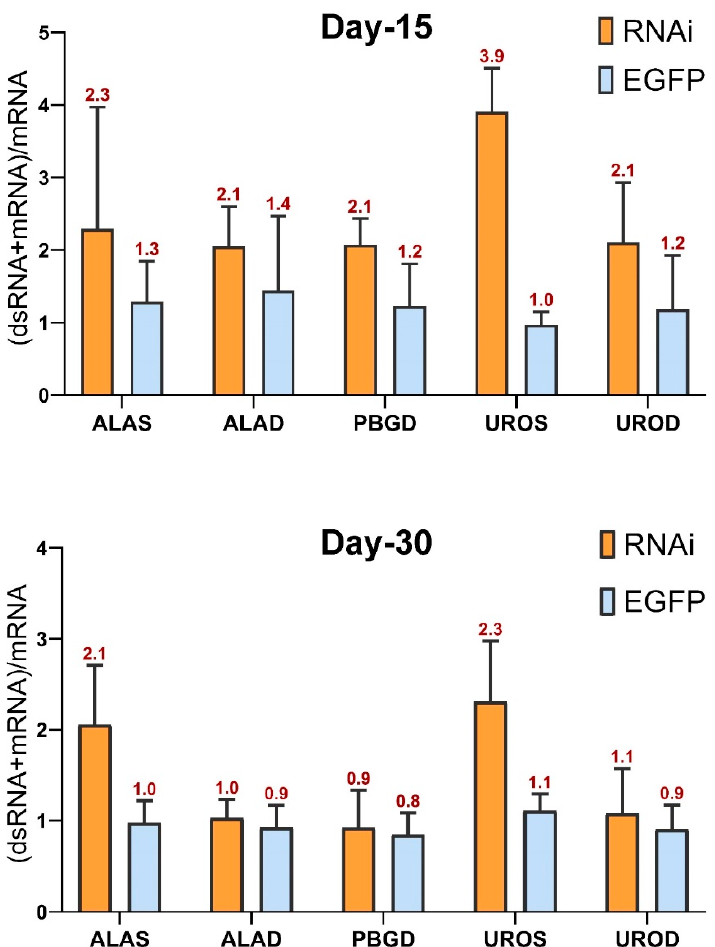
Figure 4. Detection of RNAi products in mantle tissues. The ratio of the interfering CgALAS , CgALAD , CgPBGD , CgUROS , CgUROD dsRNAs to the endogenous CgALAS , CgALAD , CgPBGD , CgUROS , CgUROD mRNA level are in marked red on the top of each column. The orange bars represent the ratio of CgALAS , CgALAD , CgPBGD , CgUROS , CgUROD of the RNAi groups, respectively, and the blue bars represent the CgALAS , CgALAD , CgPBGD , CgUROS , CgUROD genes ratio of the EGFP group, respectively.